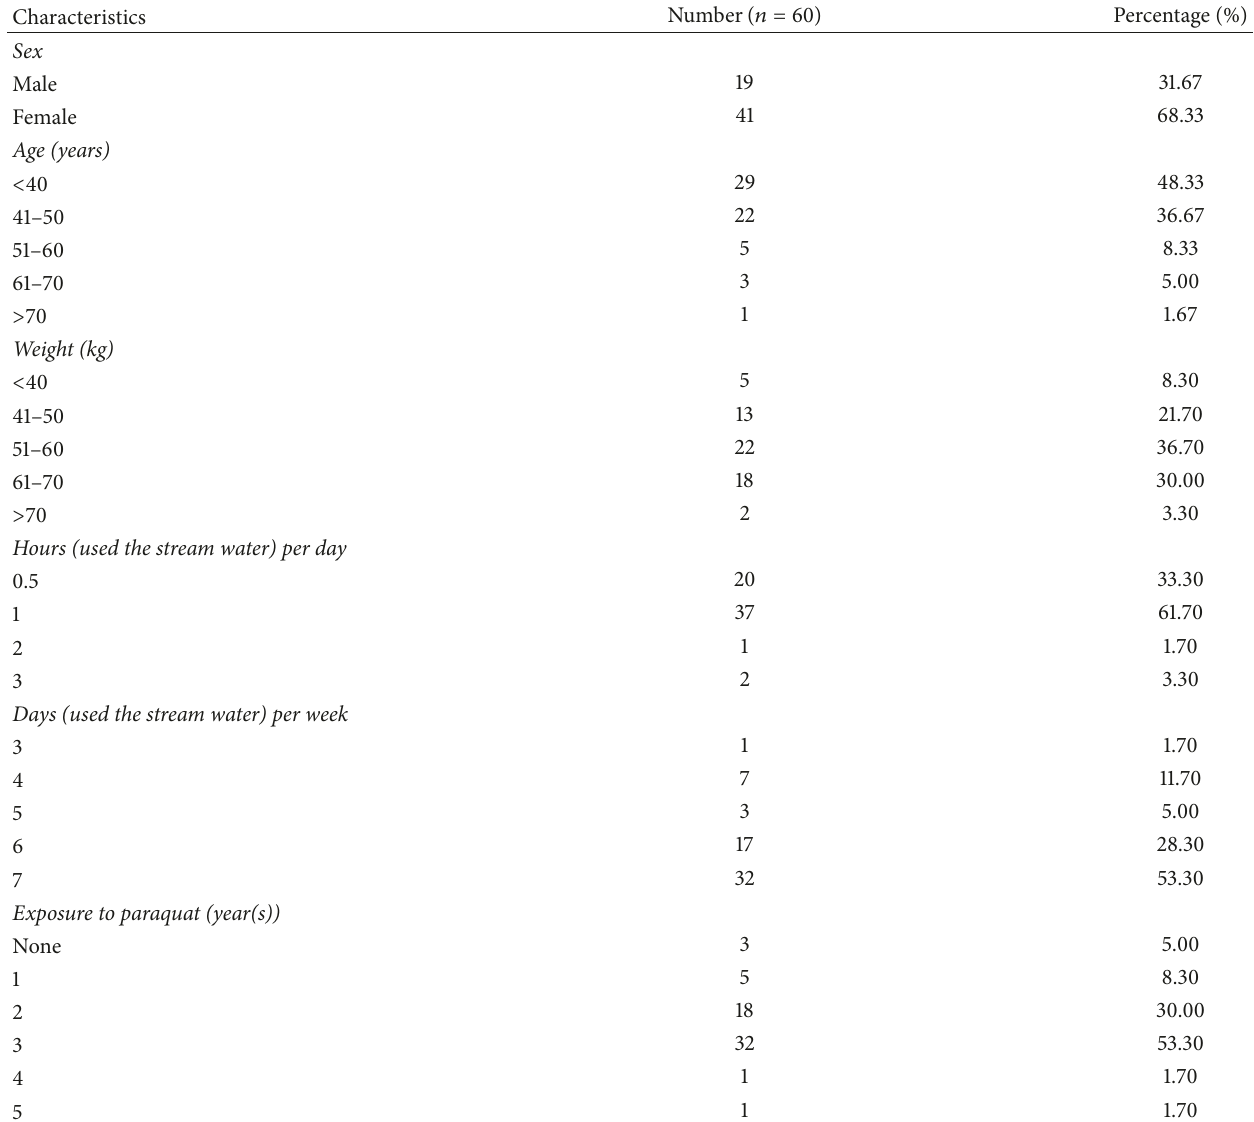
Table 2: Characteristics of residents living in the studied areas in Mai Chau